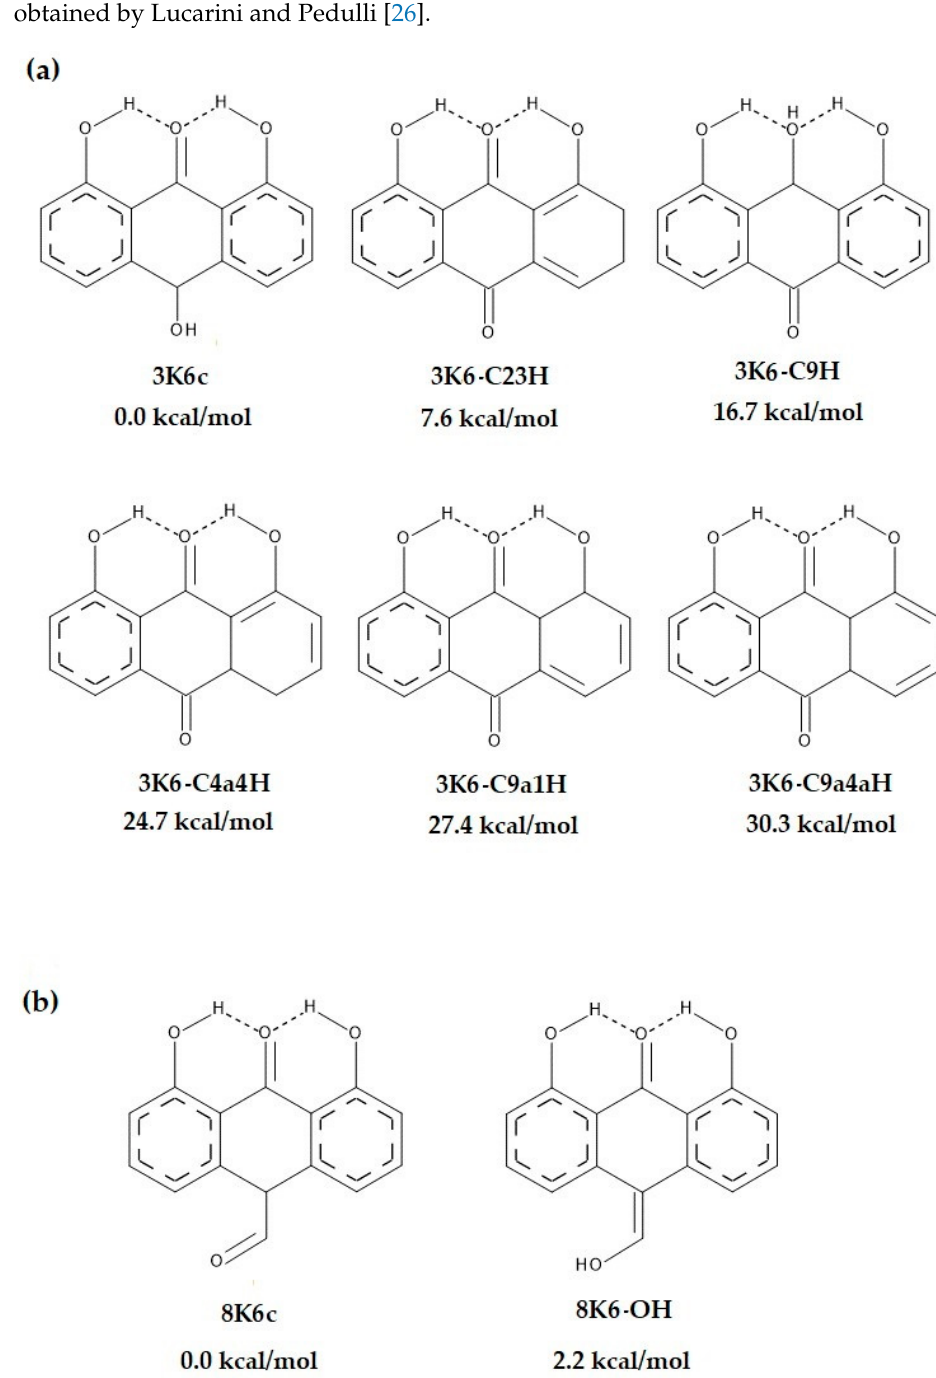
Figure 4. Prototropic tautomers and ∆ E at 298 K: ( a )—OH substituent, ( b )—CHO Figure 4 . Prototropic tautomers and Δ E at 298 K: ( a )—OH substituent, ( b )—CHO substituent .